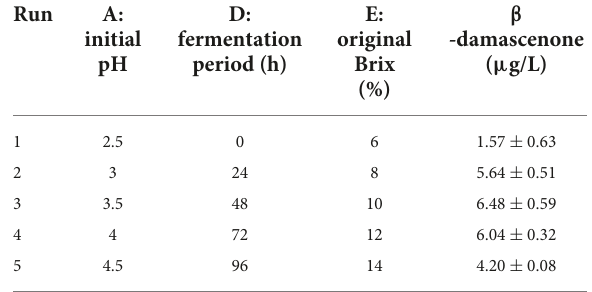
TABLE 4 Experiment design of steepest ascent and corresponding